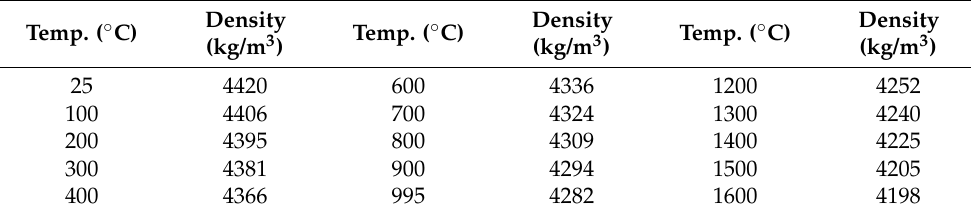
Figure 5. Thermal properties of Ti ‐ 6Al ‐ 4V as a function of temperature. Table 2. The density of Ti ‐ 6Al ‐ 4V.